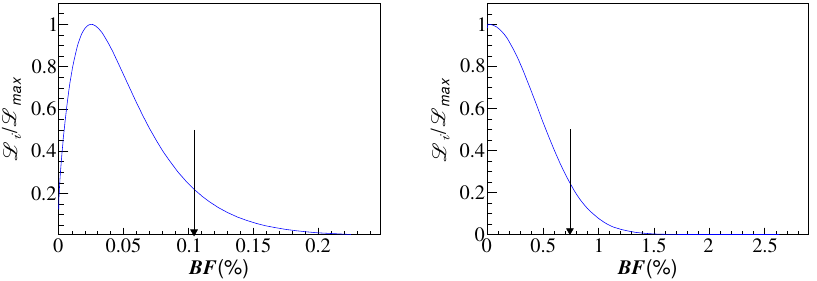
Figure 6 . Likelihood versus the BF of D + The result obtained with incorporating the systematic uncertainty is shown in blue curve. The L denotes the maximum likelihood obtained from the fit. The black arrows show the results max corresponding to the 90% confidence